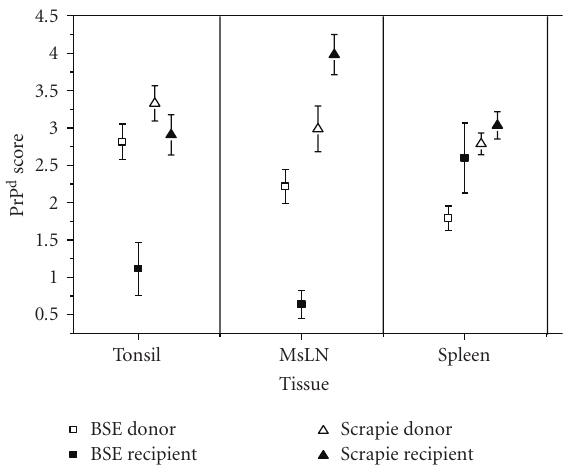
Figure 5: Magnitude of PrP d accumulation in LRS tissues of sheep as part of the blood transfusion experiment [95]. BSE donor sheep showed the highest levels of PrP d accumulation in palatine tonsil and mesenteric lymph node (MsLN) but the lowest in the spleen. In contrast, the spleen in BSE-transfused sheep showed significant higher magnitudes of PrP d . Graphic representation including scrapie data has been modified from [96,